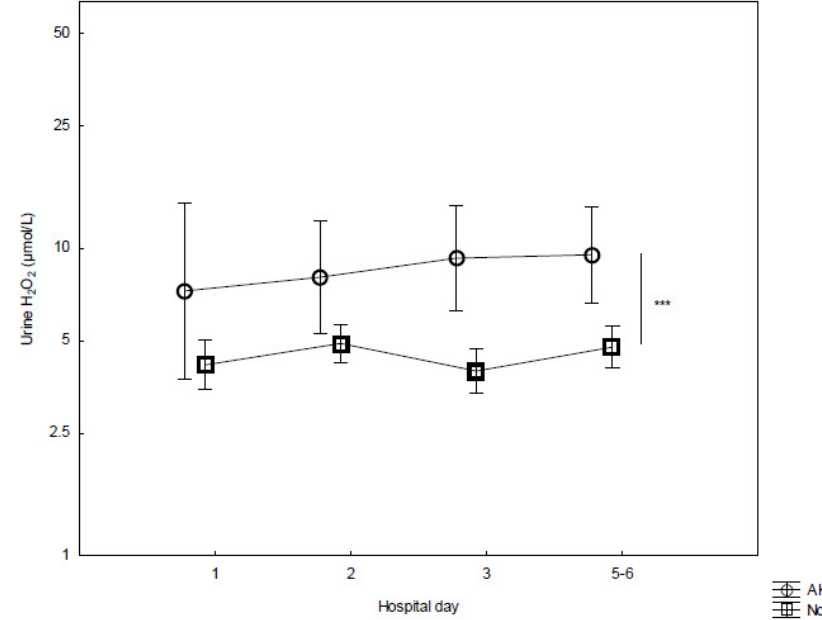
Figure 3. Concentrations of urine H 2 O 2 from admission (day 1) to day 5–6 in the ICU, stratified by patients with acute kidney injury (AKI) ( n = 12) and without AKI ( n = 70). ANOVA III for repeated measures was used to assess differences over time. Mean ± SEM. *** p < 0.001.